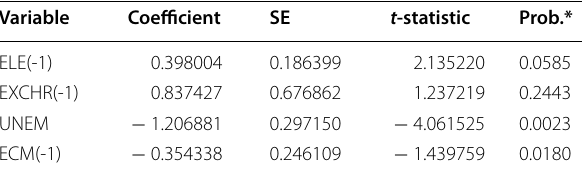
Table 6 Short-run results of ARDL model